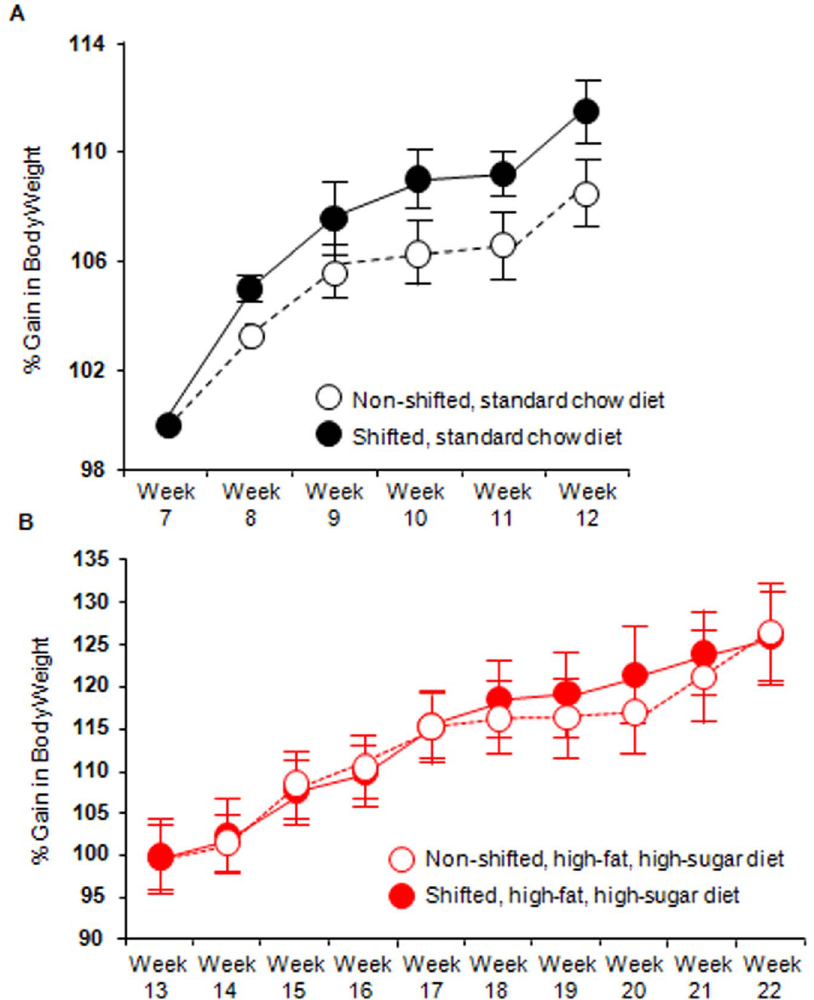
Figure 9. Circadian disruption has a significant effect on body weight. Mice were weighed once weekly and the body weights of mice consuming either the Standard chow diet (A) or the high-fat, high-sugar diet (B) are depicted over the last six weeks of each diet calculated as a percent of either Week 7 or Week 17, respectively. (A) Both circadian rhythm disruption (F (1,90) =4.93, p=0.04) and time (F (5,90) =20.24, p , 0.0001) had a significant impact on body weight when mice were consuming the standard chow diet. (B) There was no effect of circadian disruption on body weight in the high-fat, high-sugar diet-fed mice (F (1,159) =0.03, p=0.85) while time did have a significant impact (F (9,159) =43.14, p , 0.0001).